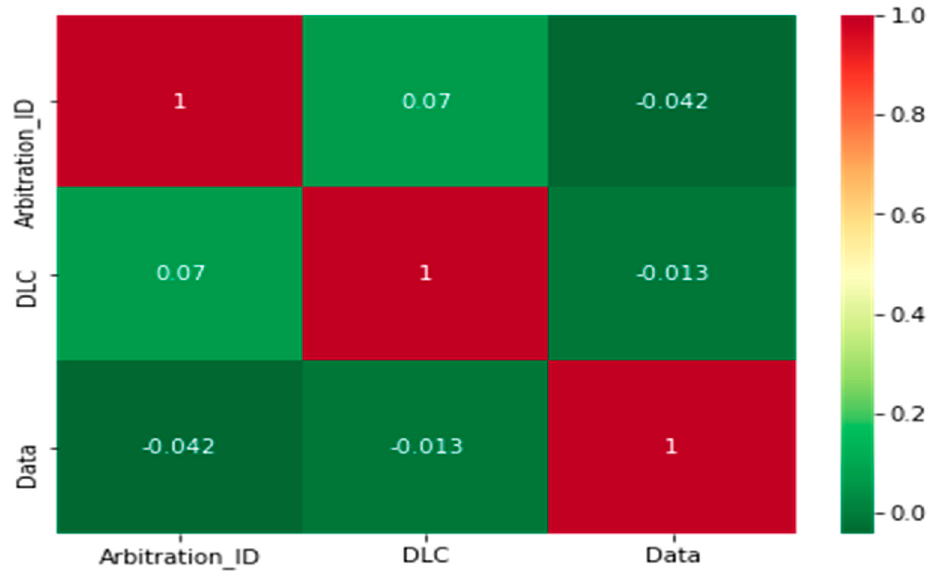
Table 7. Statistical analysis.